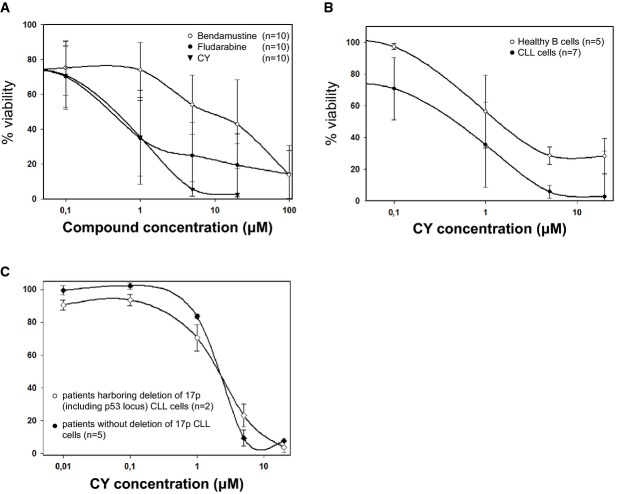
CY exhibited activity with CLL samples
Dose curve of CY, fludarabine, and bendamustine using fresh CLL samples. Data represent mean ± SD.

CY preferentially killed CLL cells over healthy B cells. Data represent mean ± SD.

Toxicity of CY190602 in patients harboring deletion of chromosome 17p (including p53 locus) compared to patients without del17p. Viability of samples was normalized to background apoptosis for individual patient samples. For all experiments, cell viability was determined after 72 h of drug treatment. Data represent mean ± SD.